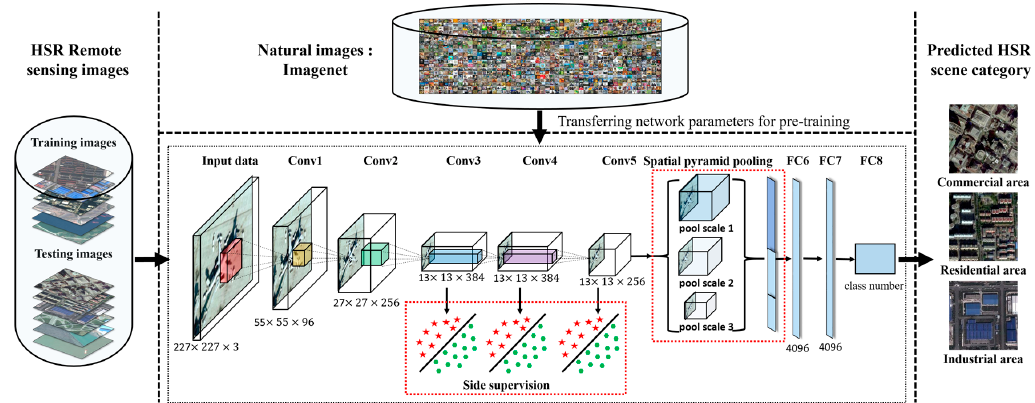
Figure 4. The pre-trained AlexNet architecture with spatial pyramid pooling and side supervision.